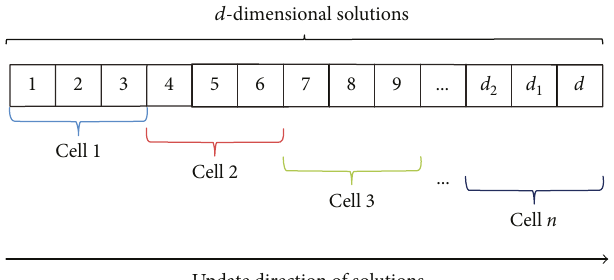
Figure 3: Updating mechanism based on evolution of dimension